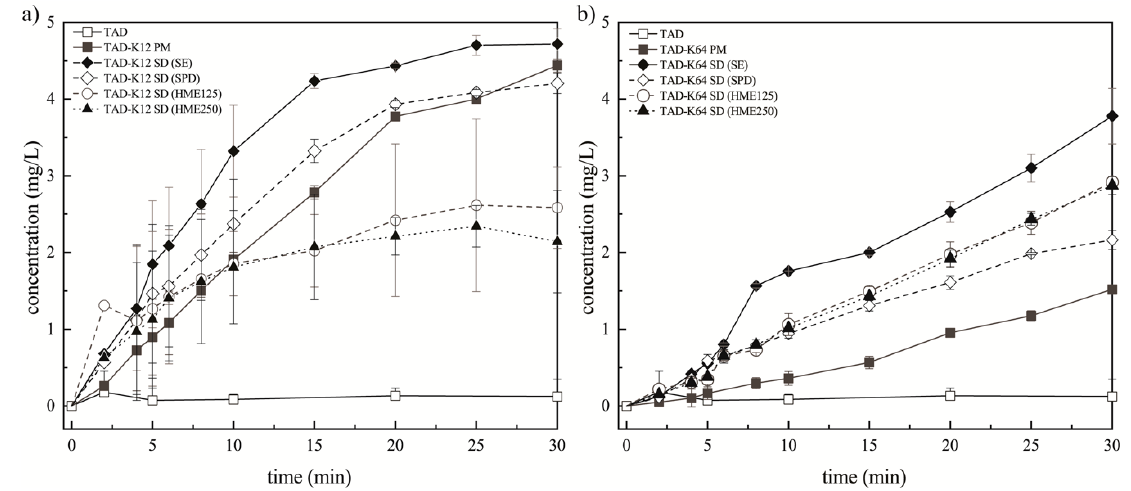
Figure 9. Release profiles of TAD from PMs and SDs prepared by different methods measured as apparent IDR using Wood´s apparatus: ( a ) K12 groups and ( b ) K64 groups.